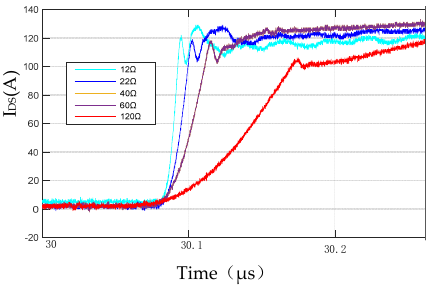
Figure 11. Drain current waveforms with different resistors.